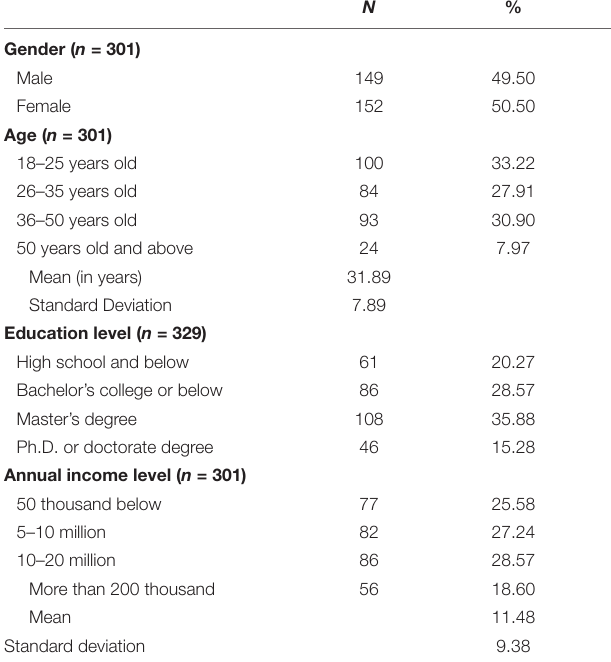
TABLE 1 | Participants’